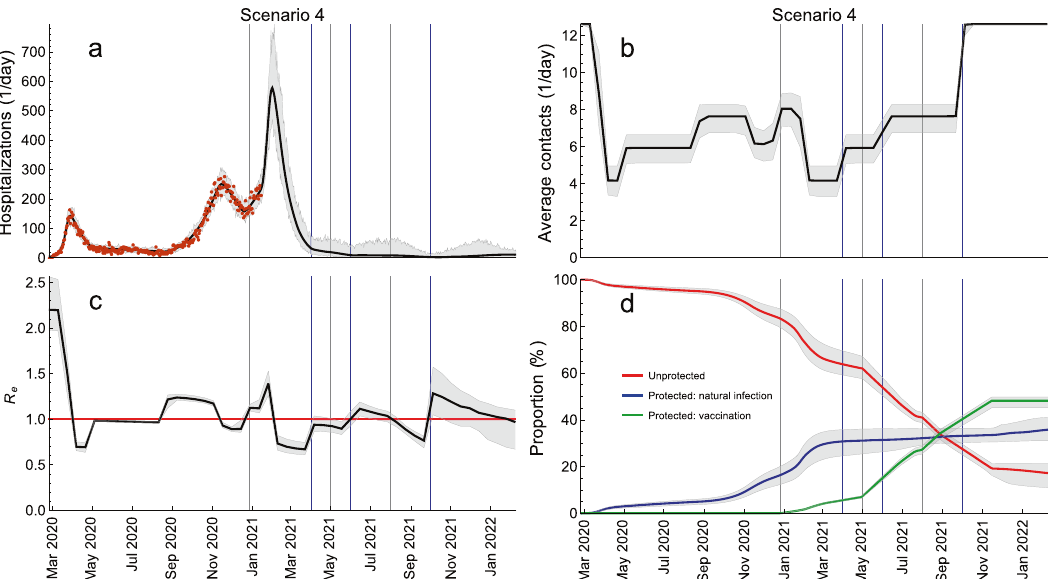
Fig. 7 Sequential relaxation of control measures. This scenario consists of sequential relaxation of measures so that the contact rates increase, in sequence, to the level of June – August 2020, of September – October 2020 and the pre-pandemic level. The blue vertical lines indicate the mid-points of these transitions (1 April, 1 June, 1 October). The gray vertical lines indicate the starting dates for different vaccination phases (Table 1). The red horizontal line denotes R e = 1. The hospitalization data are shown as red dots. The thick solid lines are the median trajectories estimated from the model. The gray shaded regions correspond to 95% credible